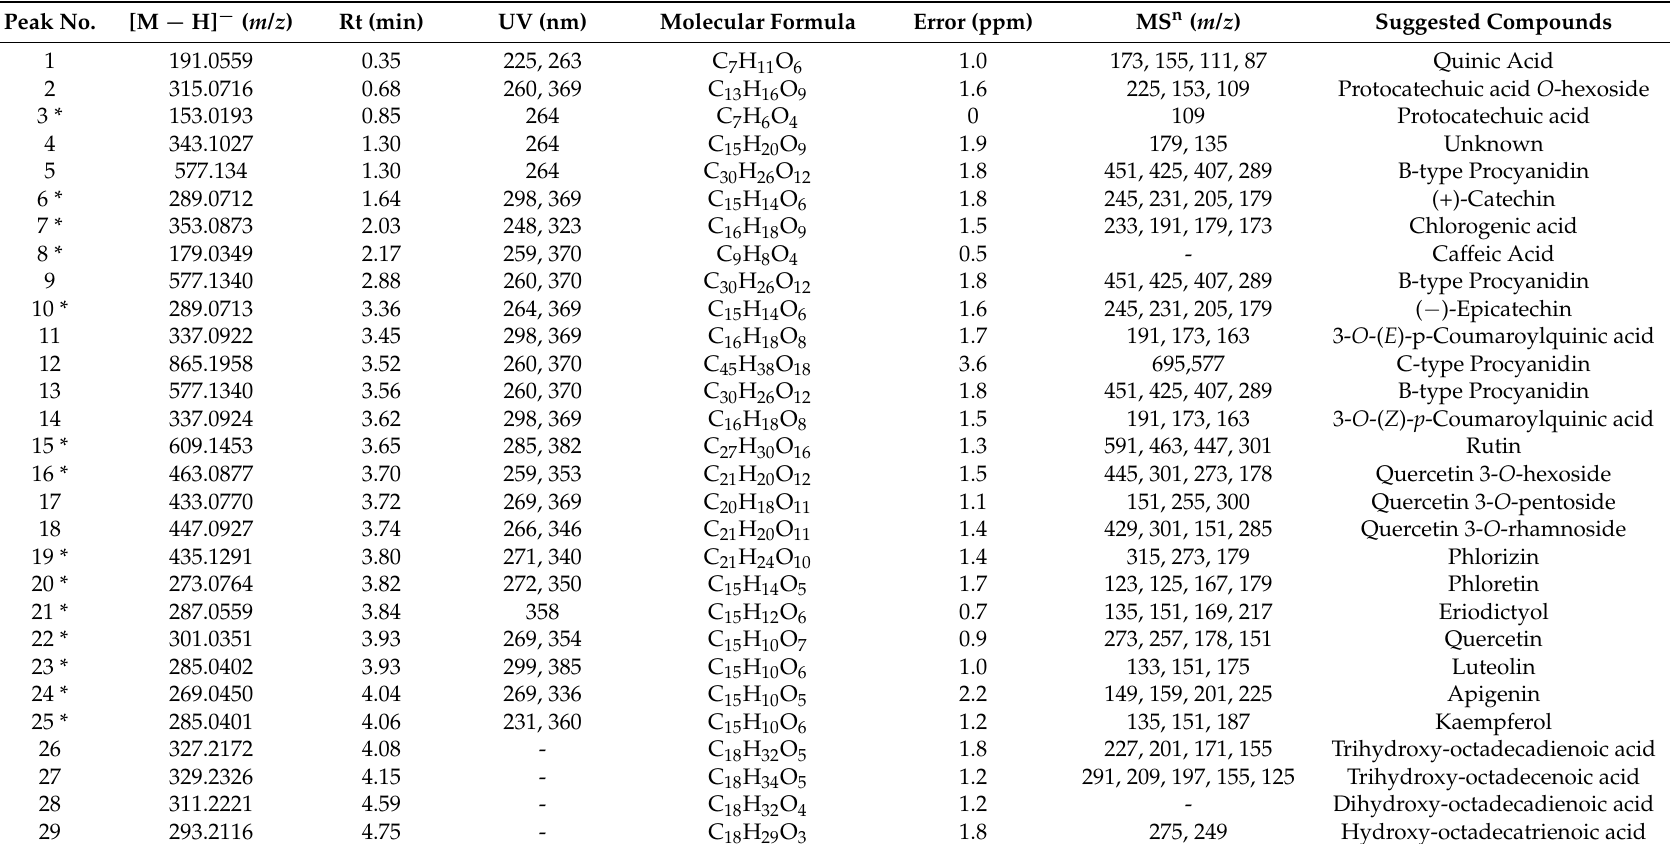
Table 1. Characterization of phenolic compounds and fatty acids in the leaves of Hancornia speciosa through UHPLC-HRMS/MS analysis in negative ionization mode. Peak